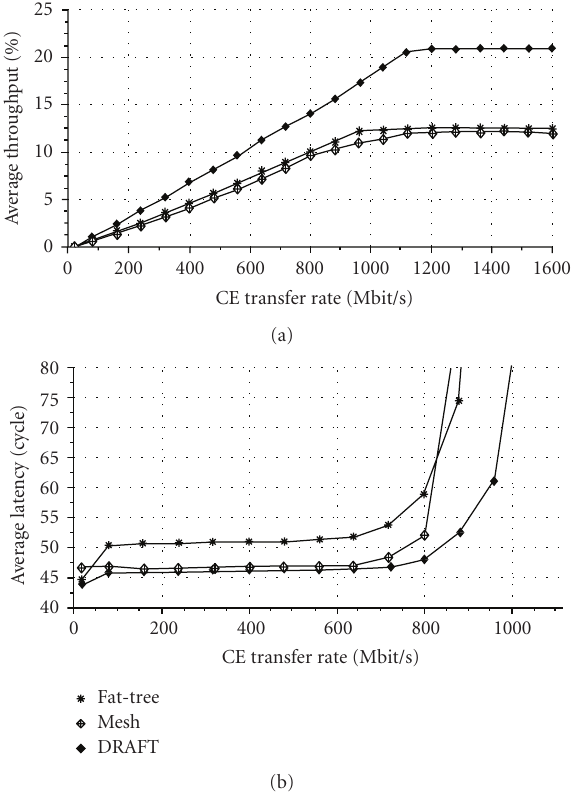
Figure 13: Comparison of the average throughputs (a) and latencies (b) depending on each CE transfer rate.